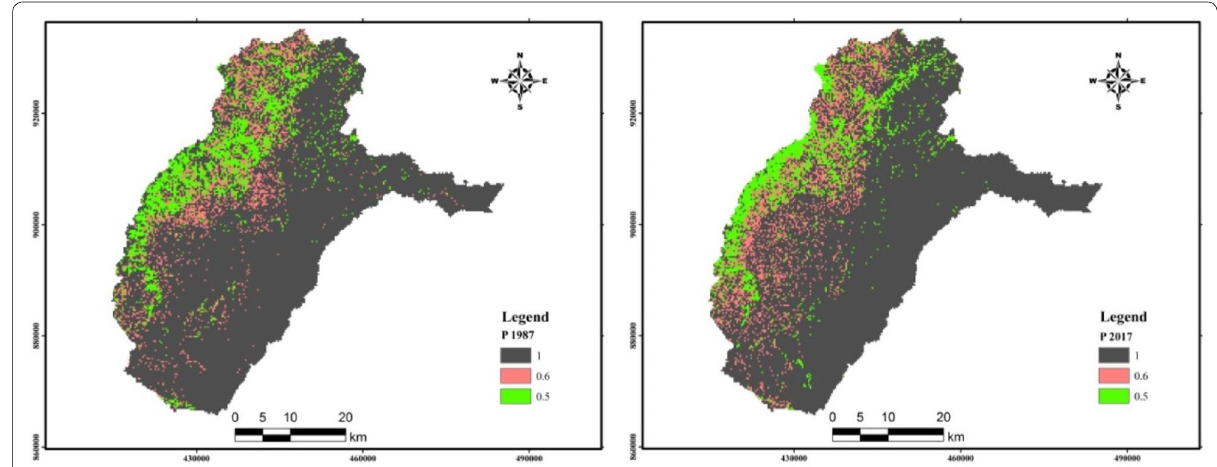
Fig. 12 Management factor map of Meki watershed in 1987 and